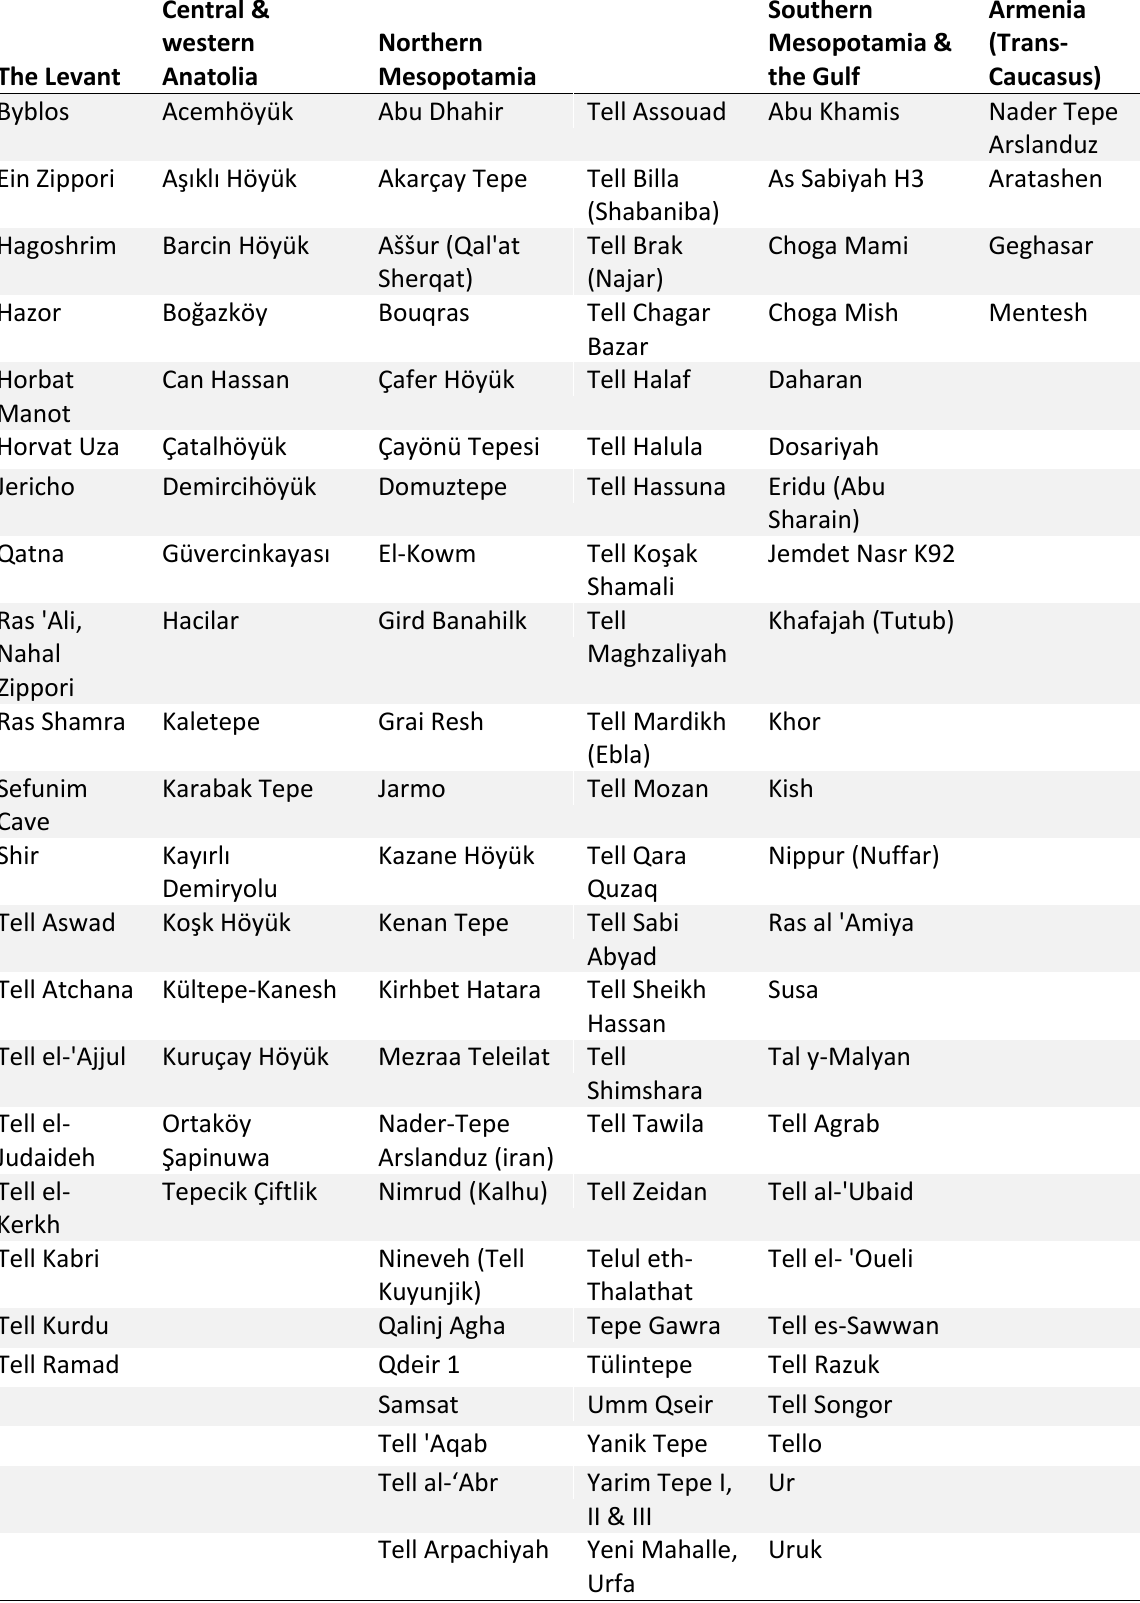
Table 1. List of sites by region. Note: the regions are broadly defined and that the northern Levant and northern Mesopotamia